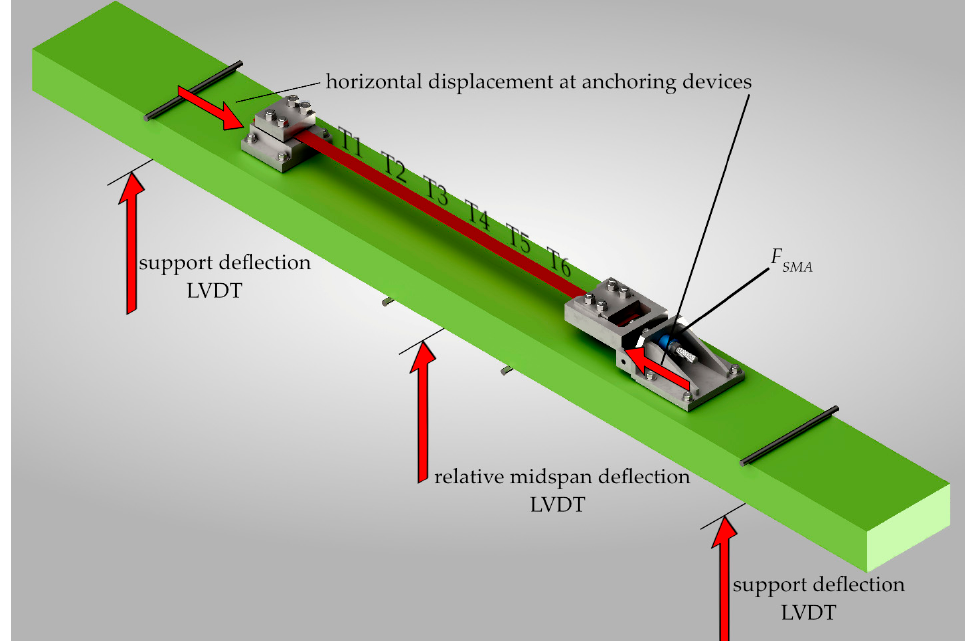
Figure 7. Monitoring setup at the beam. LVDT: linear variable differential transformer; ( F SMA ): force in the SMA strip.